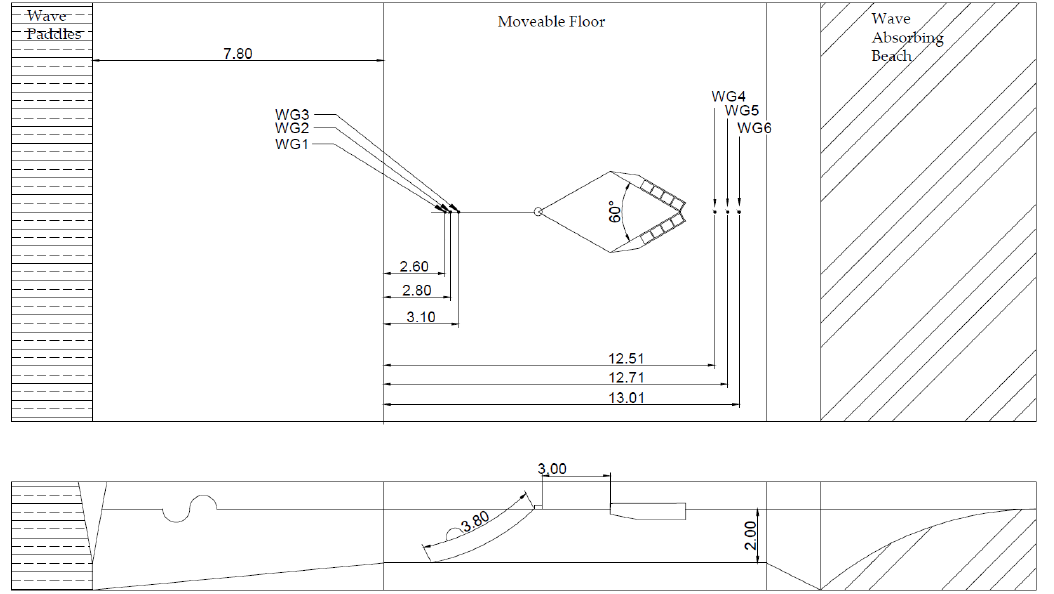
Figure 4. The experimental setup showing wave gauges, model and floor position in plan view, above, and section view, below. Dimensions in m.